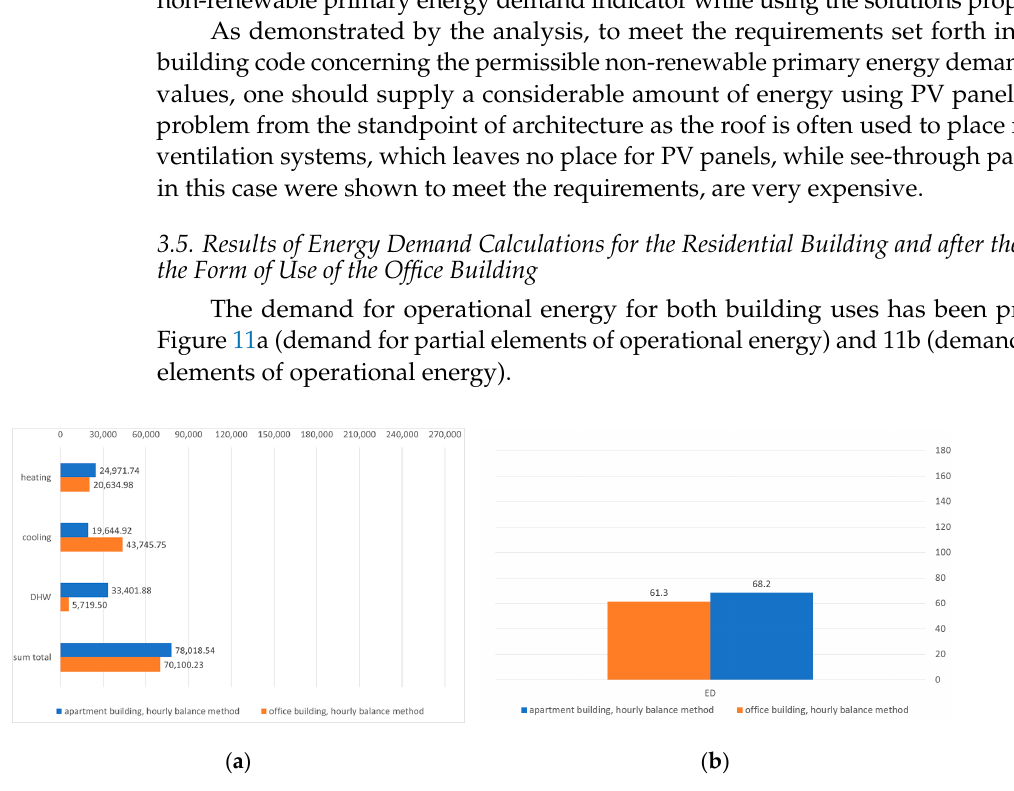
Figure 11. Operational energy. ( a ) Operational energy for both building uses with cooling. ( b ) Operational energy indicators for both building uses with cooling.